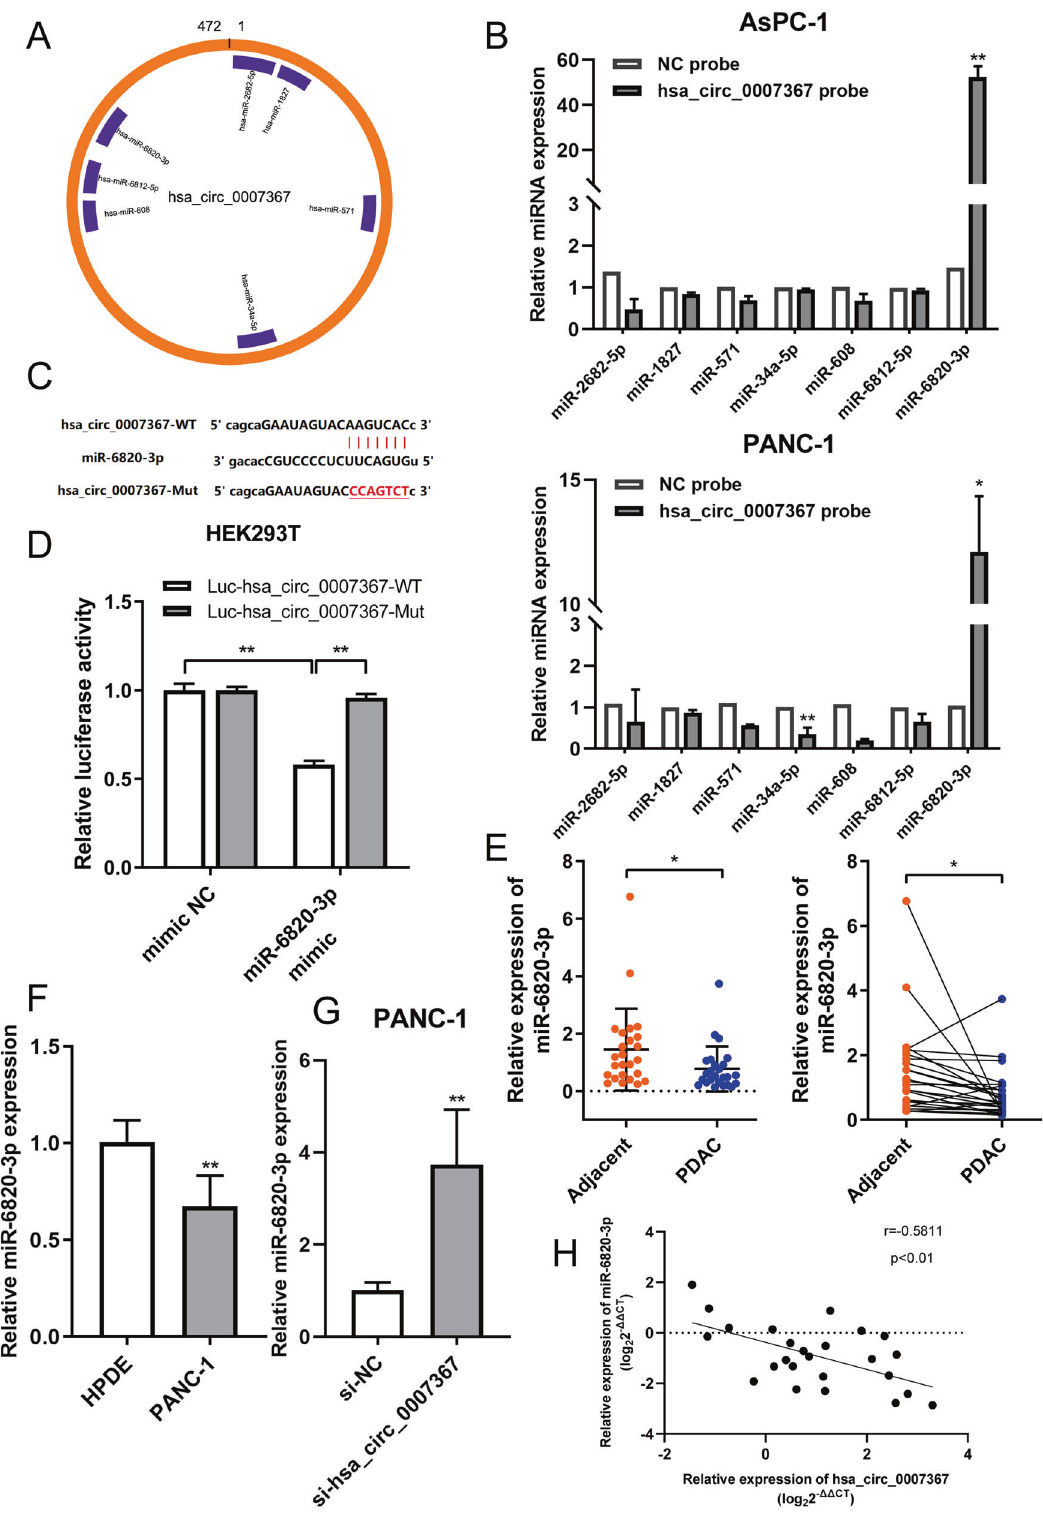
Fig. 4 Hsa_circ_0007367 functions as a sponge for miR-6820-3p in PDAC. A Schematic drawing showing potential target miRNAs of hsa_circ_0007367 predicted by starbase, circbank, and circular RNA interactome. B The relative expression of seven potential target miRNAs in PANC-1 and AsPC-1 cells lysates were detected by qRT-PCR. MiR-6820-3p was stably pulled down by hsa_circ_0007367. C Schematic illustration of the wild-type (WT) and mutant (mut) hsa_circ_0007367 luciferase plasmid. D The luciferase activities of the hsa_circ_0007367 luciferase reporter vector (WT or mut) in HEK293T cells transfected with miR-6820-3p mimics or mimic NC. E , F qRT-PCR detected the relative expression of miR-6820-3p in PDAC tissues ( E ) and in HPDE and PANC-1 cell lines ( F ). G The relative expression of hsa_circ_0007367 in PANC-1 cells was detected by qRT-PCR after hsa_circ_0007367 knocking down. H Correlation analysis between hsa_circ_0007367 and miR-6820-3p expression in PDAC tissues. All data are shown as the mean ± SD of at least three independent experiments. * p < 0.05, ** p < 0.01. Cell Death and Disease (2022)